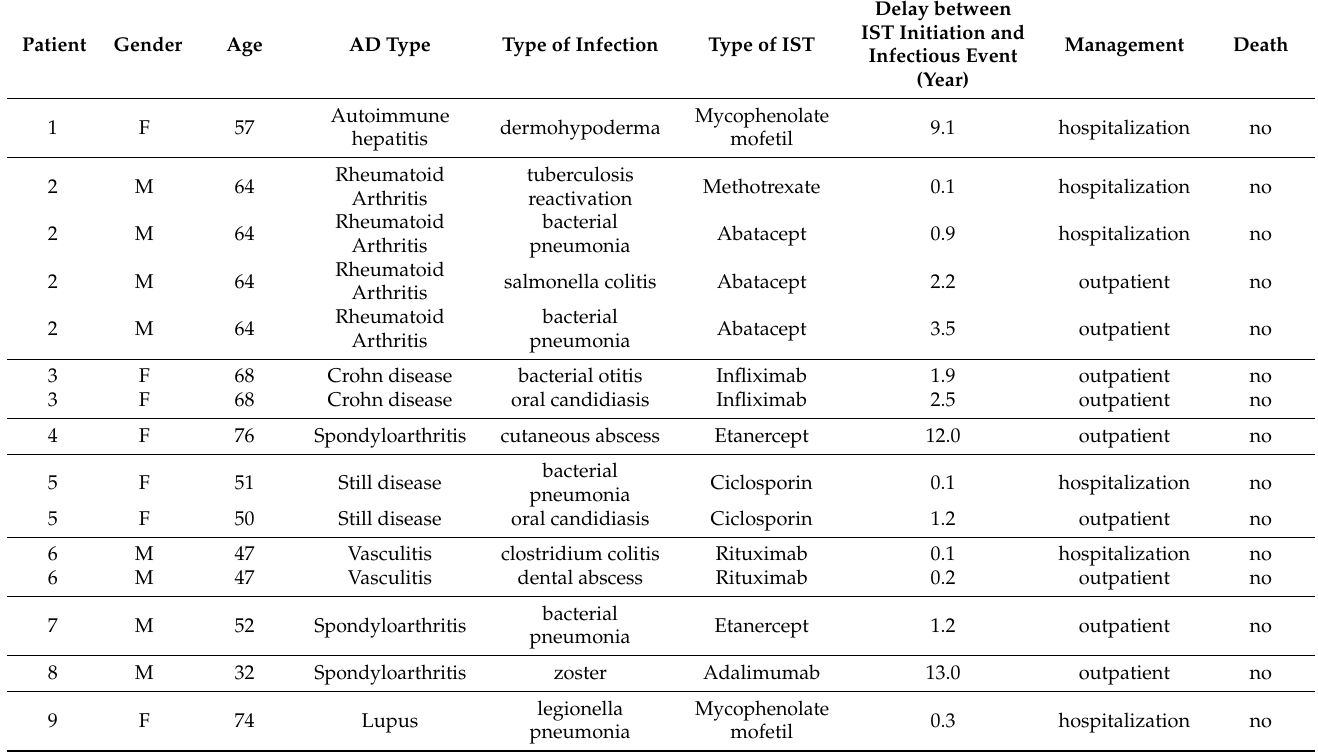
Table 3. Description of the infectious